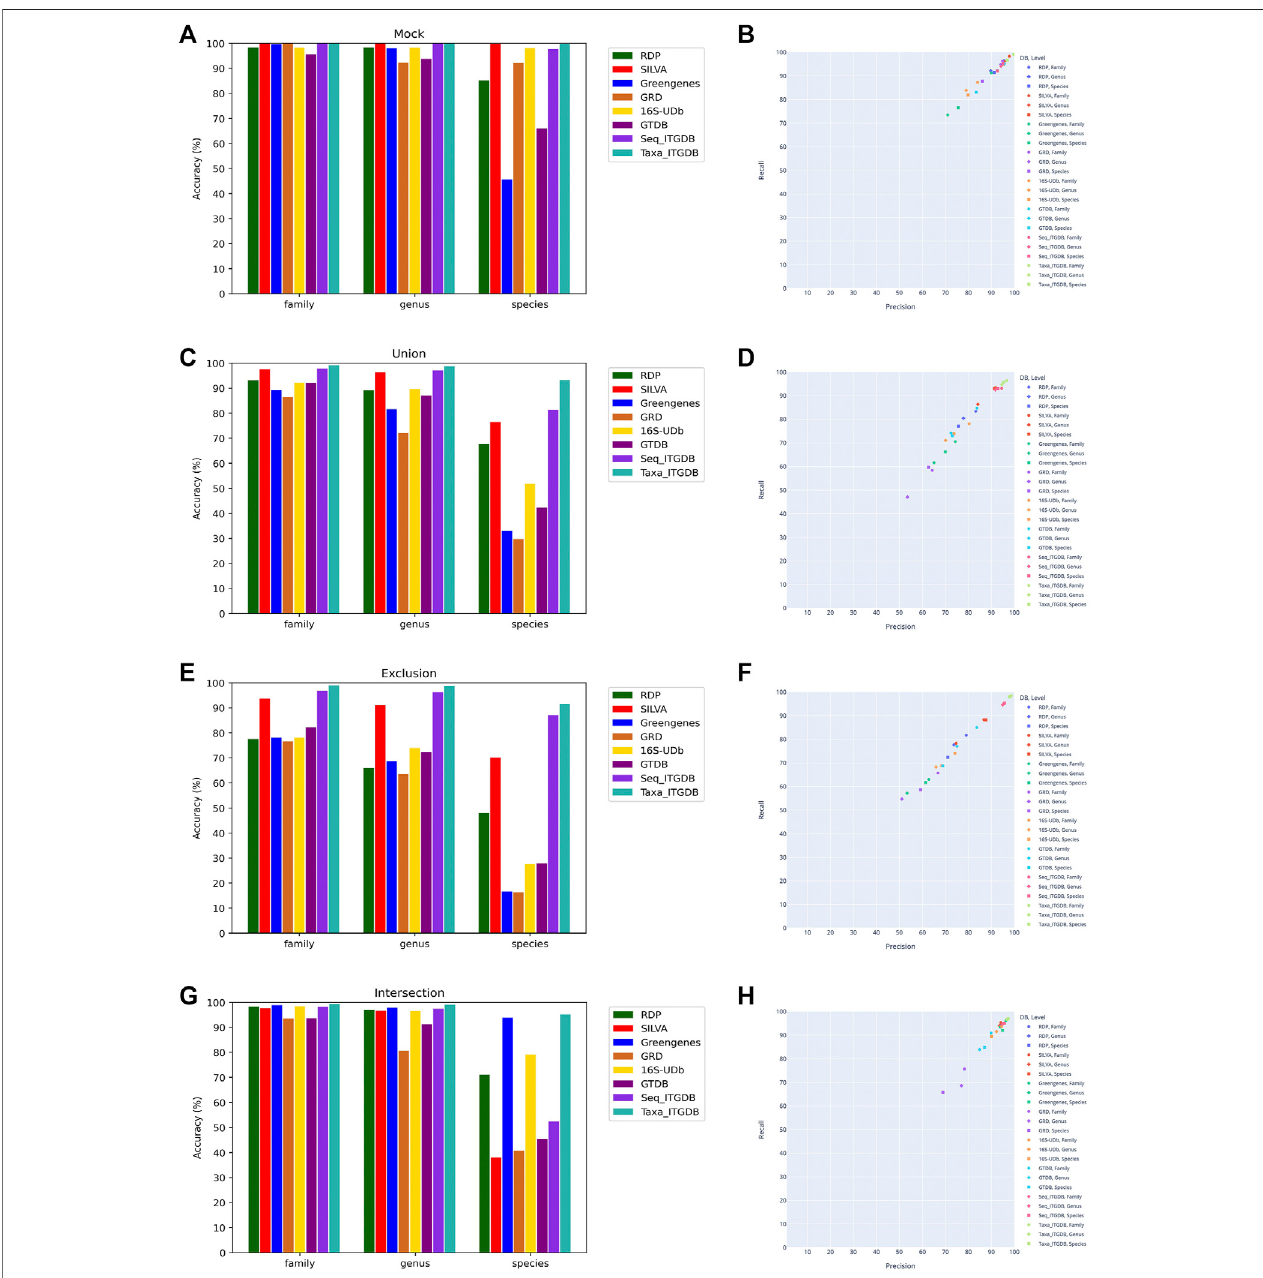
FIGURE 3 | Performance comparison of using different reference databases to classify sequences in the combined mock community, Union, Exclusion, and Intersection datasets. Accuracy of classifying the mock community (A) , Union dataset (C) , Exclusion dataset (E) , and Intersection dataset (G) . Precision and recall of classifying the mock community (B) , Union dataset (D) , Exclusion dataset (F) , and Intersection dataset (H) .